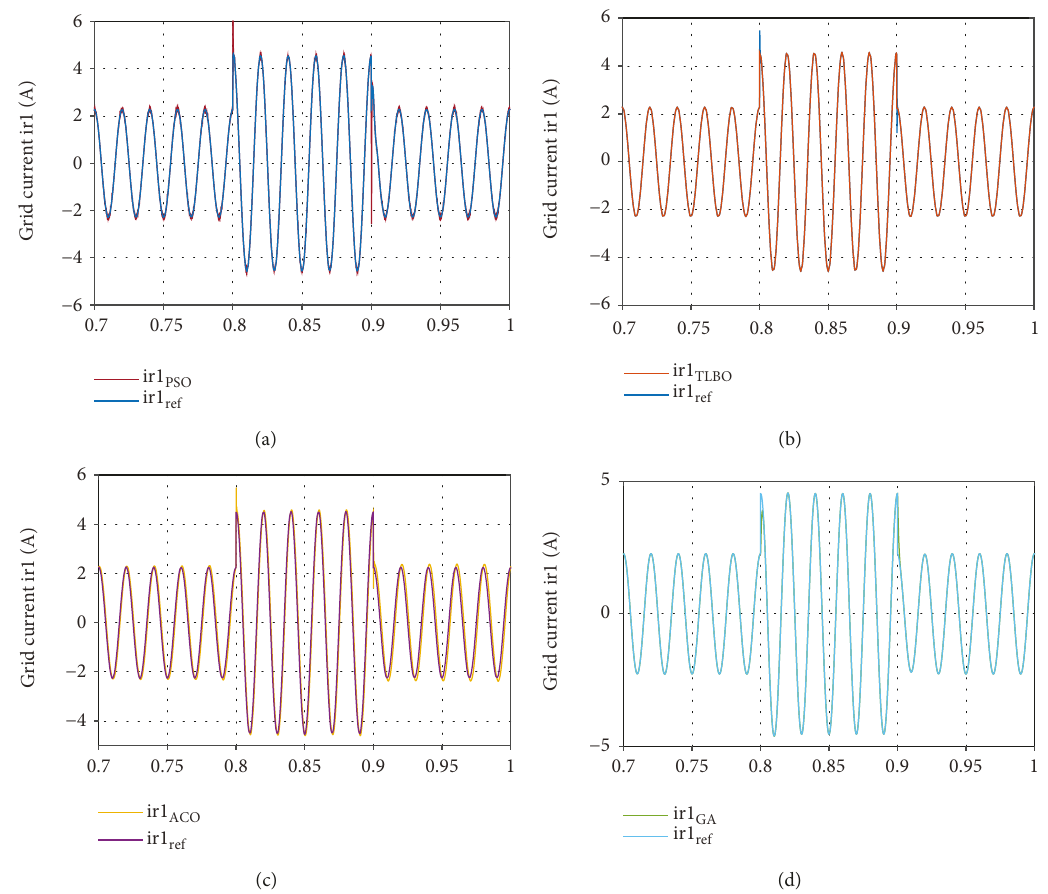
Figure 15: Voltage dip e ff ect on grid currents without limitation by using (a) PSO-PID; (b) TLBO-FOPID; (c) ACO-PID; (d)